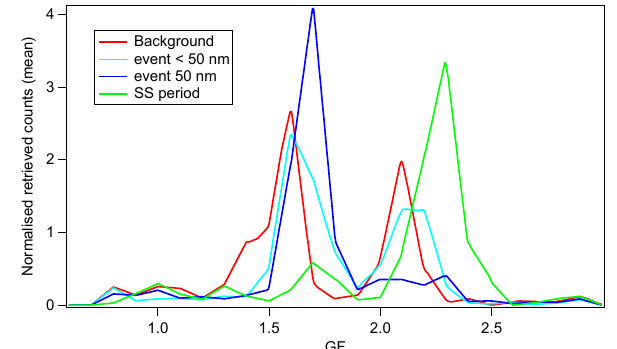
Figure 3. Time-integrated air history plot showing the recent surface (0–100m) influence of the air arriving at Mace Head between 15:00 and 18:00 on 24 May 2011. The darker colors represent greater influence. This transport pattern was characteristic of the nanoparticle enhancement period of 23–24 May.